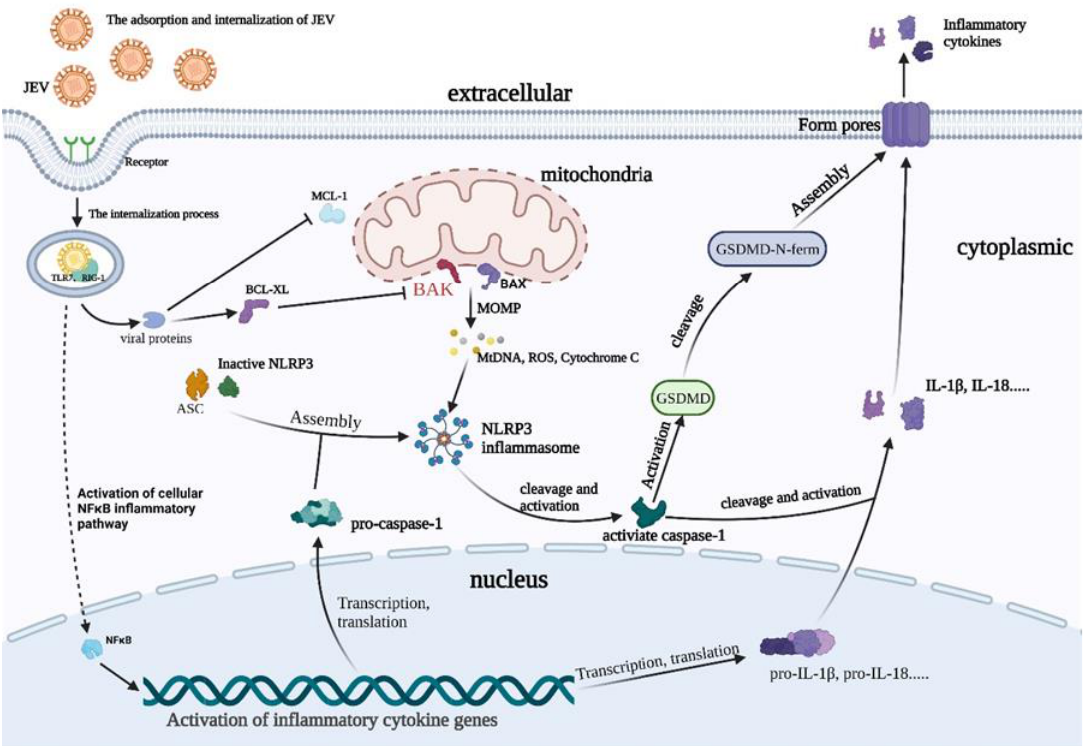
Figure 6. When JEV enters the release phase of the life cycle, JEV can promote BAK activation to activate the MOMP process. Subsequently, the release of ROS promotes the combination of pro- caspase-1, ASC, and pro-NLRP3 to form the NLRP3 inflammasome, forming an activated form of caspase-1. Then, caspase-1 activates inflammatory factors such as IL-1β and cleaves the N-segment of the GSDMD protein. Finally, the GSDMD-N protein aggregates on the cell membrane to form pores, releasing IL-1β and virions.